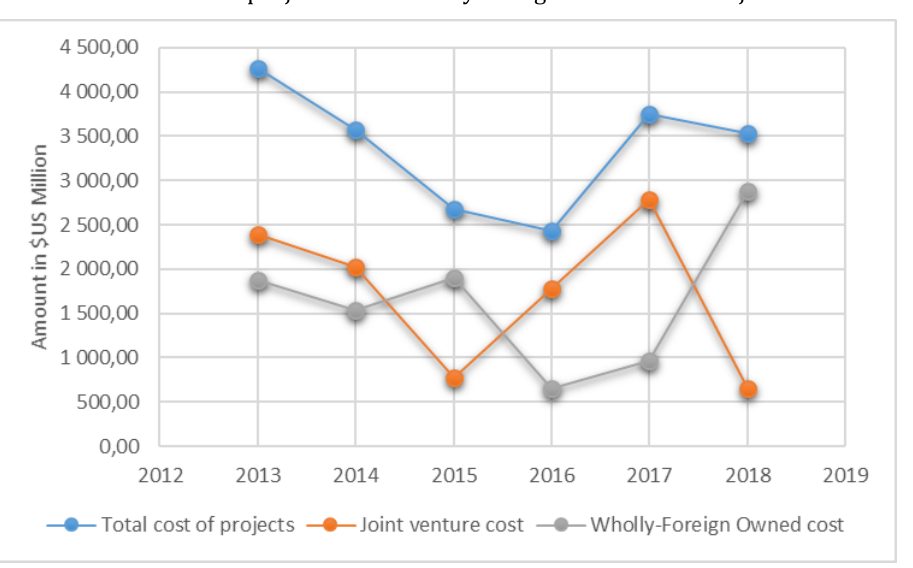
Figure 3 : Total cost of FDI projects verse wholly-foreign owned cost and joint venture cost